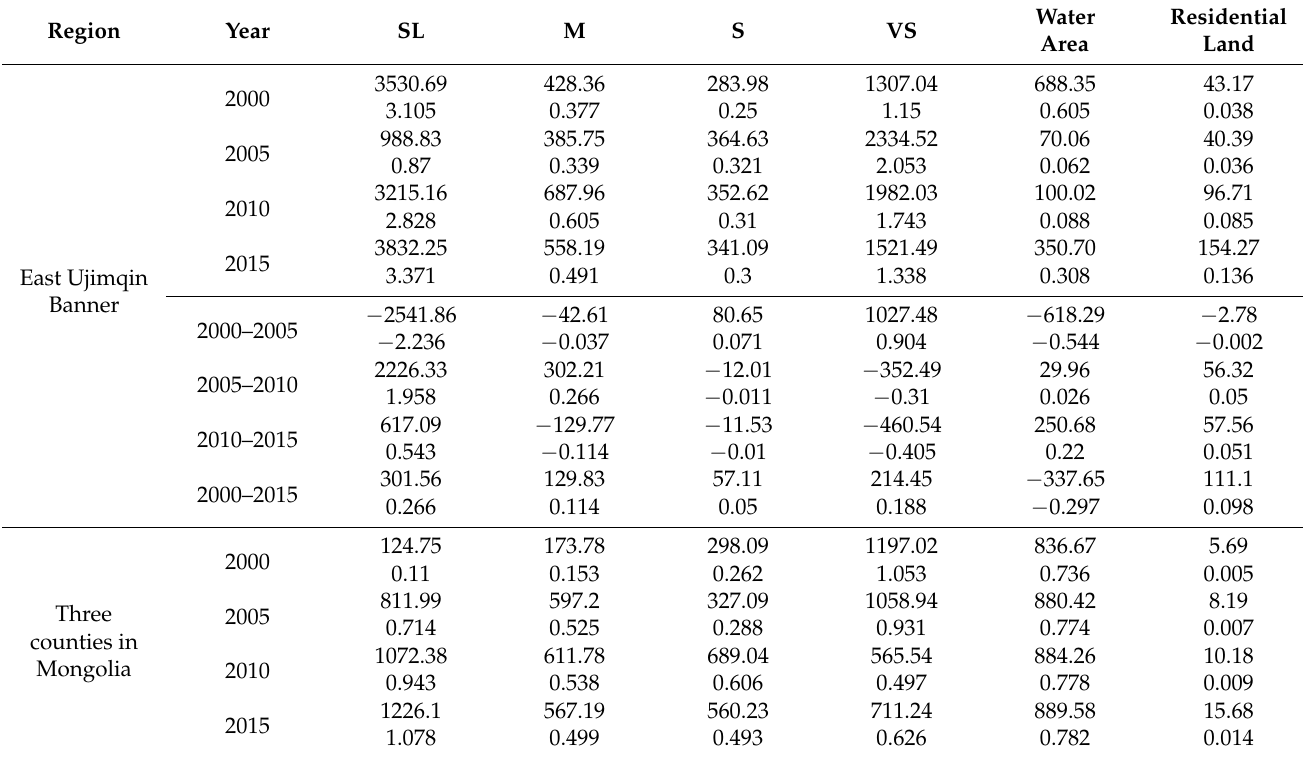
Table 3. Variation of desertified land areas (km 2 ) and its percentages